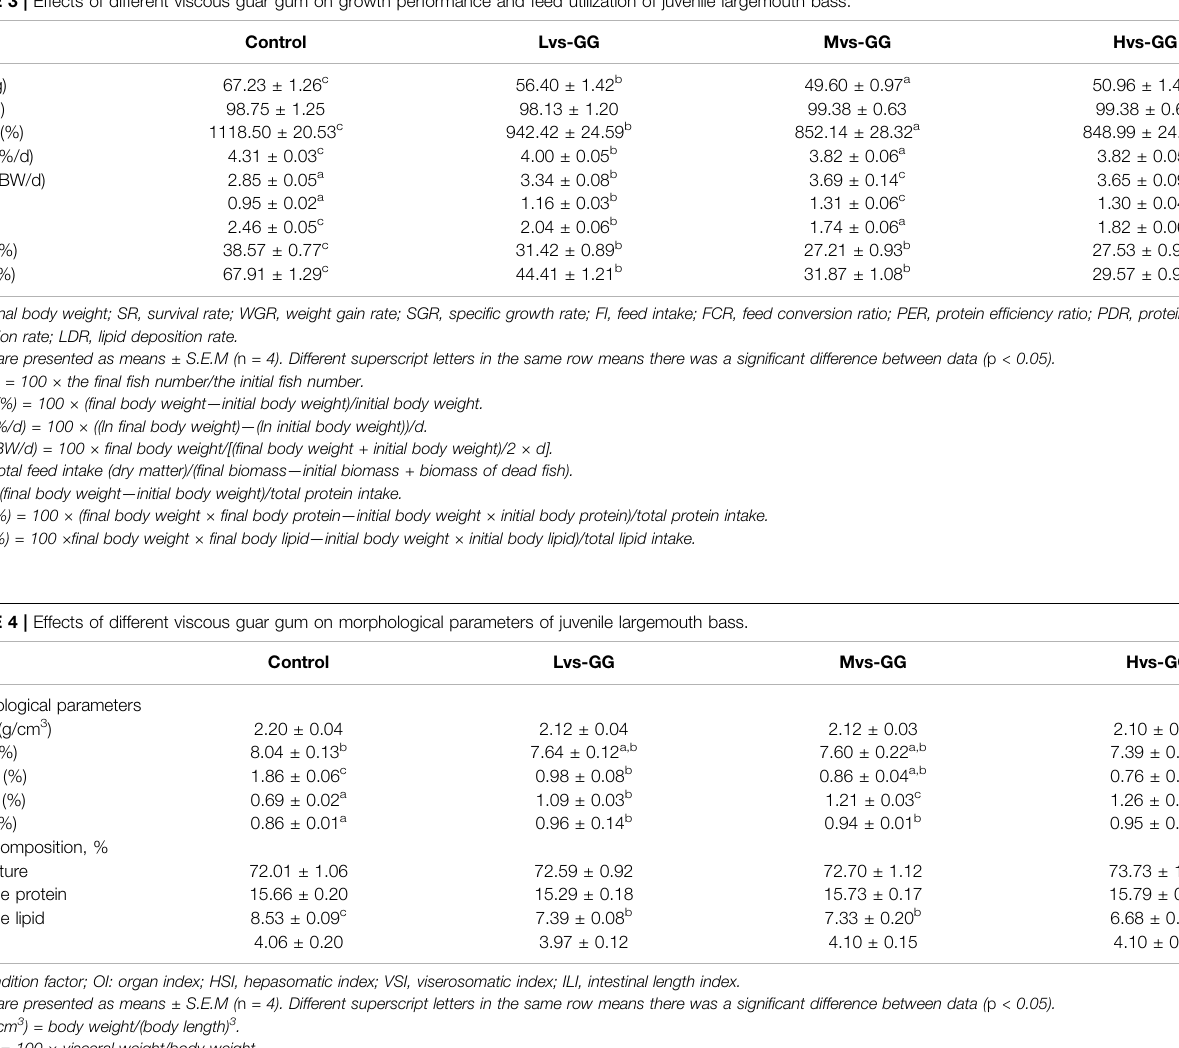
TABLE 3 | Effects of different viscous guar gum on growth performance and feed utilization of juvenile largemouth bass.